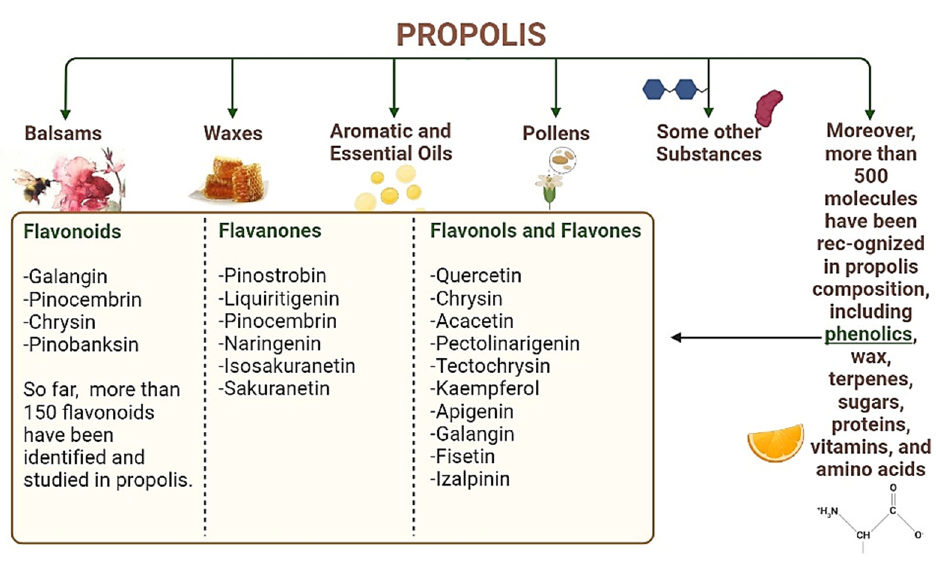
Figure 6. General composition of propolis.